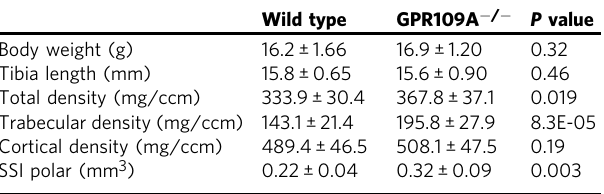
Boday weights and tibial length and Pqct parameters in 4-weeks-old wild type and GPR109A-/- (knock out) mice. Data presented as mean ± SD, p value was detected by t -test. SSI polar, strength-strain index